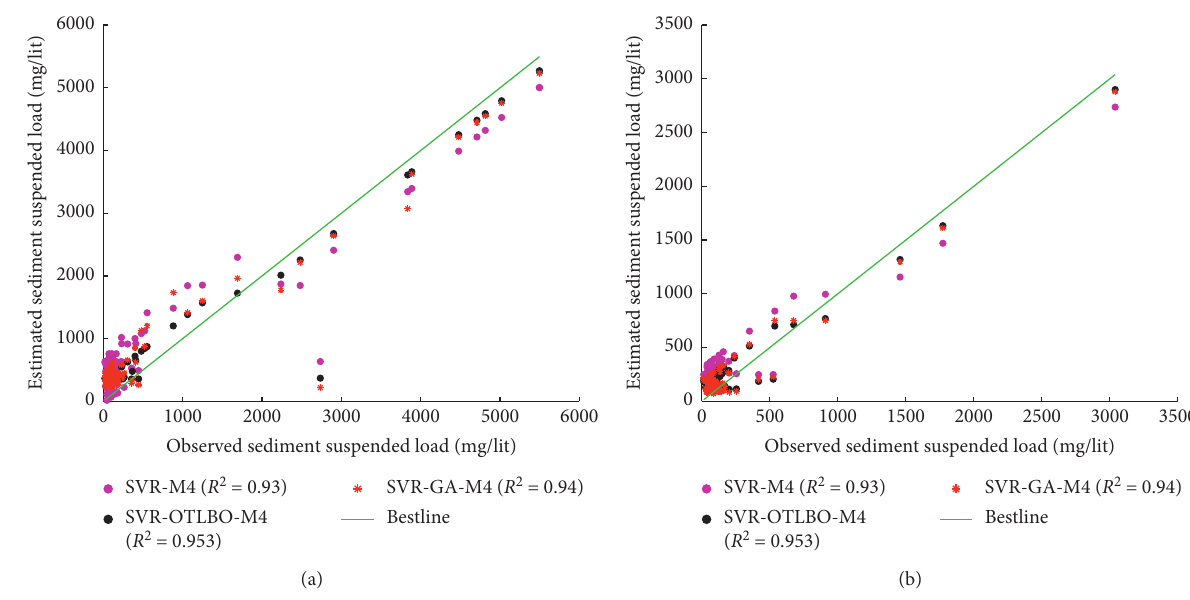
Figure 5: Scatter plots of observed and estimated suspended sediment load (mg/lit): (a) training phase and (b) testing phase.